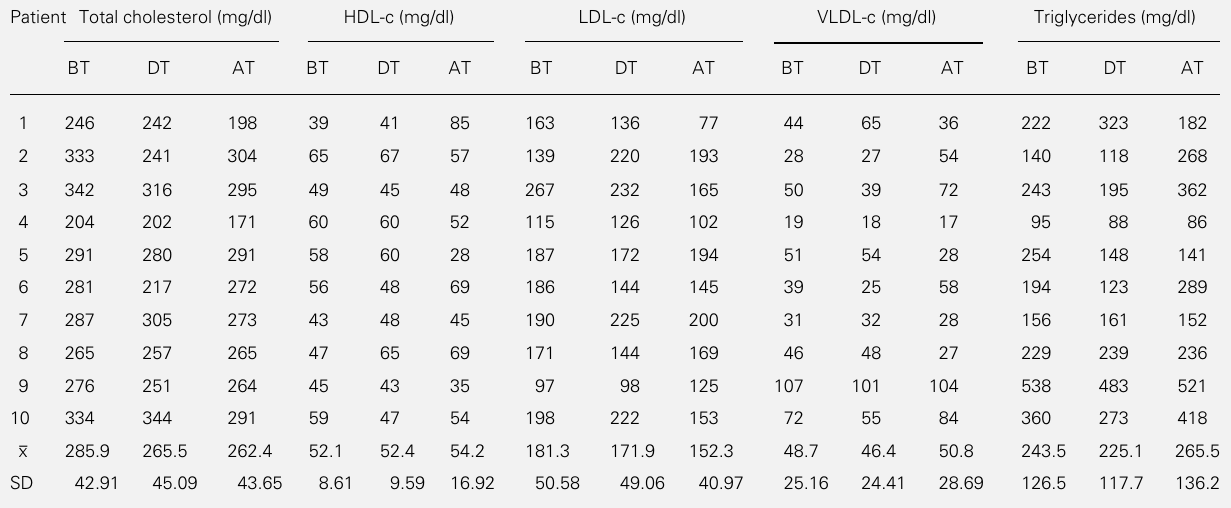
Table 3 - Lipid profile of patients receiving 17ß-estradiol percutaneously. Data are reported as individual values and as means ± SD. The Student-Newman-Kuels test showed no statistically significant difference between the mean values of the variables analyzed at periods BT (before treatment), DT (during treatment) and AT (two months after discontinuation of treatment). Patient Total cholesterol (mg/dl) HDL-c (mg/dl) LDL-c